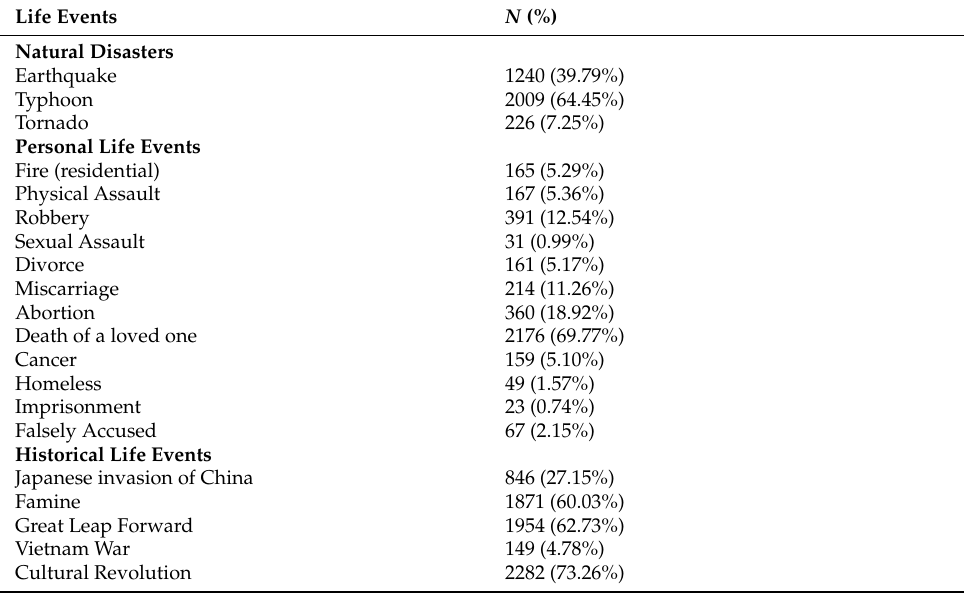
Table 1. Prevalence of life events ( N = 3125).